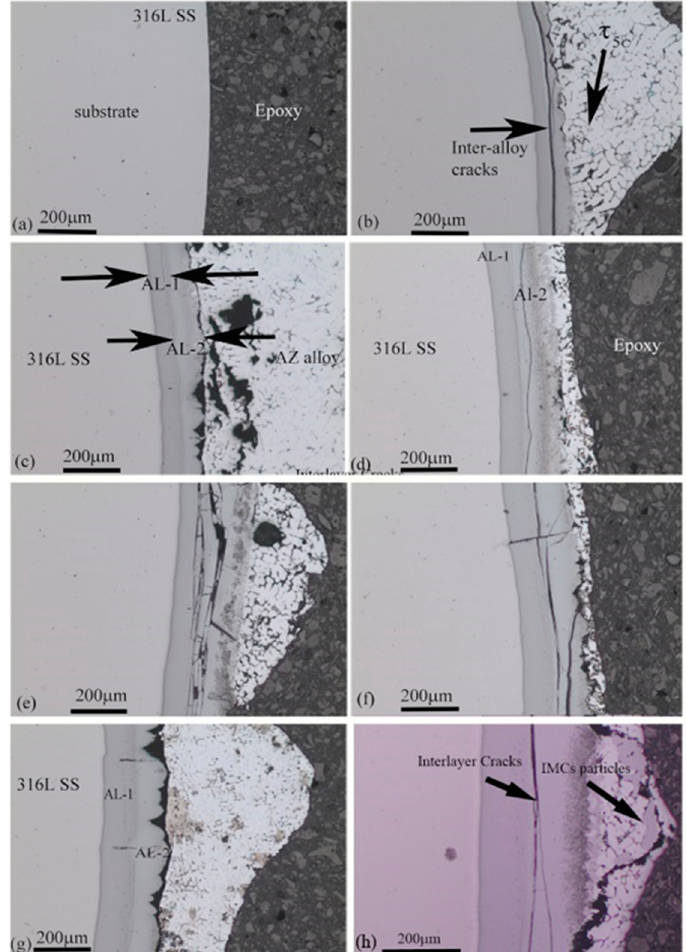
Figure 6. An optical microscopy (OM) image of AZ-alloy-immersed 316L SS samples ( a ) as received SS, ( b ) 1 day, ( c ) 2 days, ( d ) 3 days, ( e ) 4 days, ( f ) 5 days, ( g ) 6 days, ( h ) 7 days of immersion time at 600 °C.